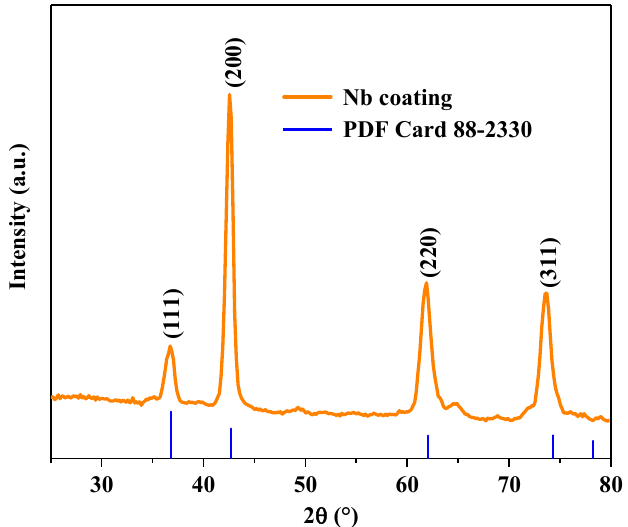
Figure 1. Typical XRD pattern for the Nb coating and the standard XRD pattern of face centered cubic (fcc) Nb (PDF Card 88-2330). Table 1. The TC hkl values for different planes of the Nb coating. Crystal